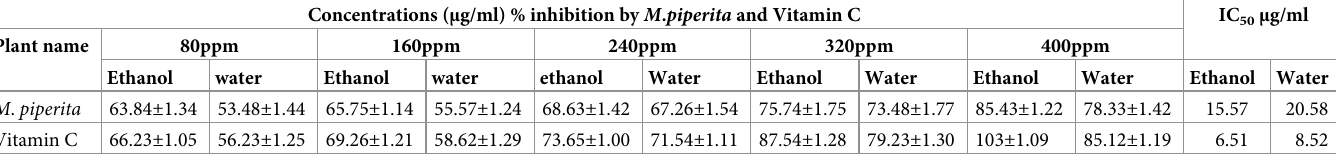
Table 3. DPPH free radical scavenging (%) activity from M . piperita of ethanolic crude extracts. Concentrations ( μ g/ml) % inhibition by M . piperita and Vitamin